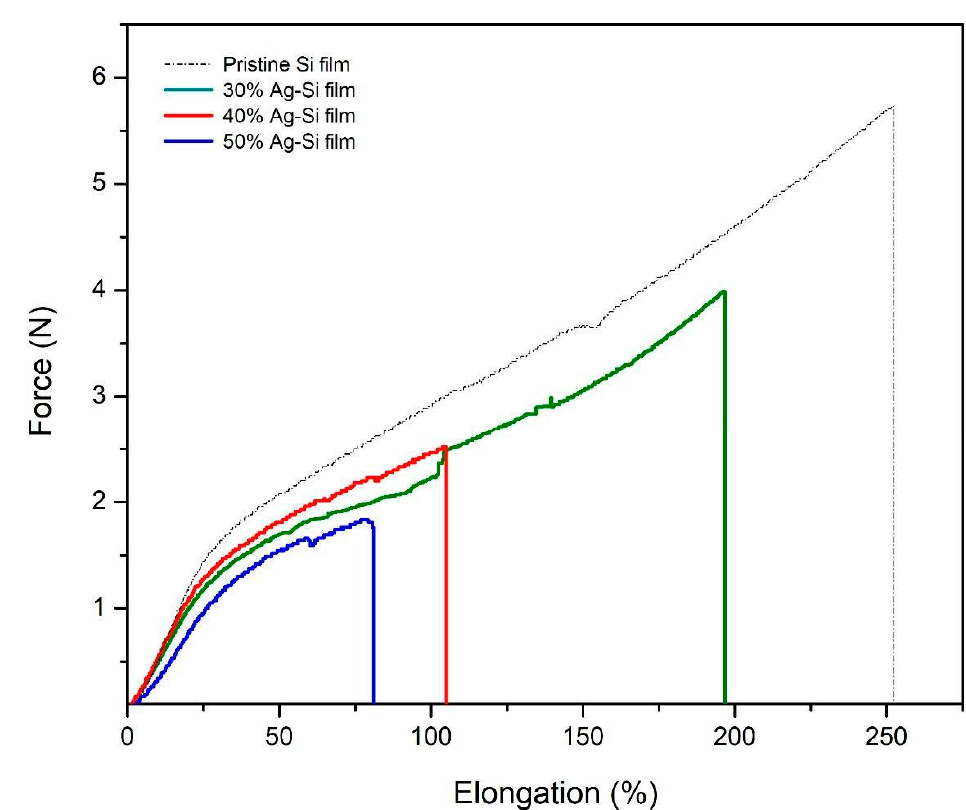
Figure 7. Tensile stress and elongation of the Si–Ag thin films as a function of different Ag compositions. Table 4. The tensile stress and elongation rate of each